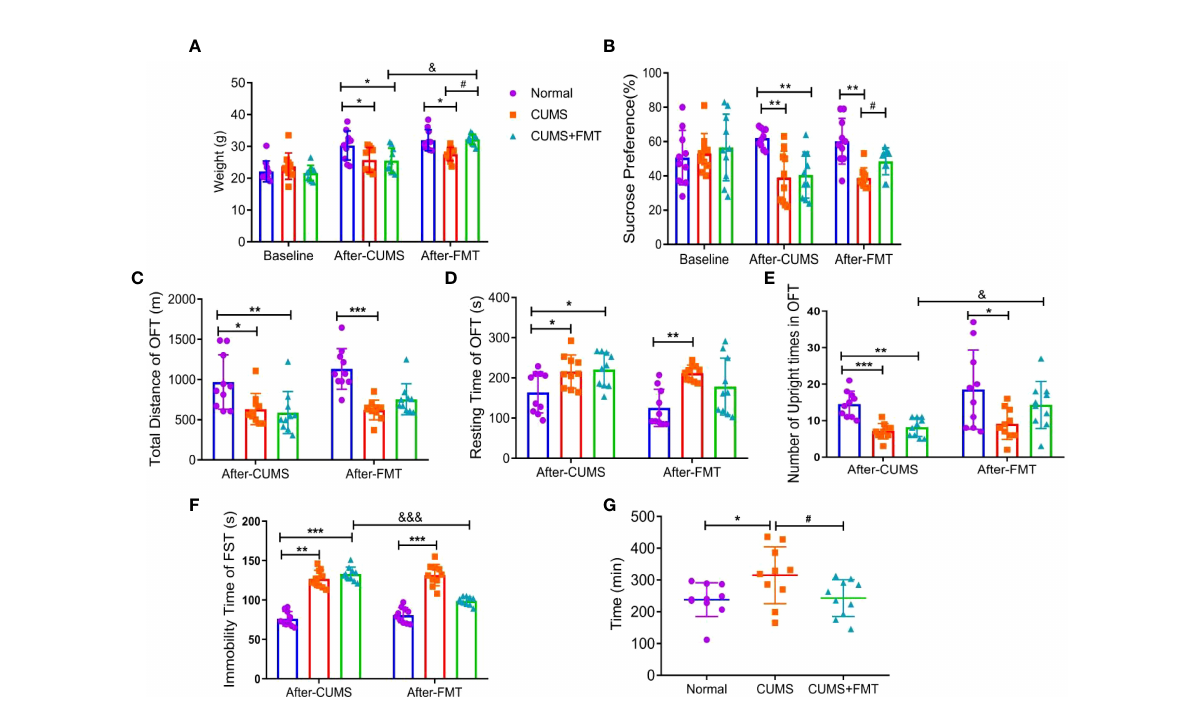
FIGURE 2 Results of behavioral experiments and glass bead discharge test. (A) Changes in the food intake in each group; (B) changes in the sucrose preference test in each group. C – E, Open- fi eld test: (C) total distance; (D) immobility time; (E) Number of upright times. (F) Forced swimming test; (G) glass bead discharge test. * p < 0.05, ** p < 0.01, *** p < 0.001 compared with the control group; # p < 0.05 compared with the CUMS group; and & p < 0.05, &&& p < 0.001 represent statistically signi fi cant differences between the values before and after FMT. Abbreviations: CUMS, chronic unpredictable mild stress; FMT, fecal microbiota